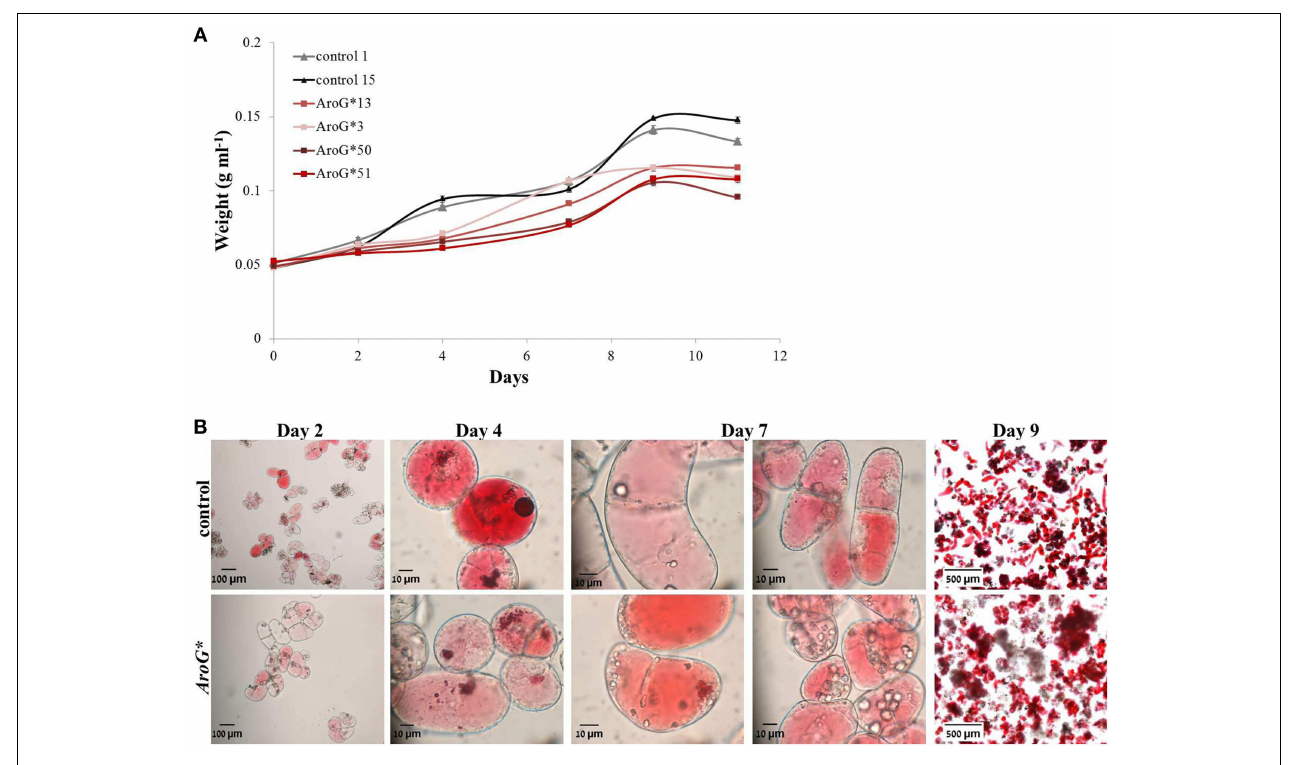
photographs (taken by a Leica MZ FLII microscope) of line 13 and control cells during their growth. Bars on top of the histograms indicate standard errors ( n = 3 ).